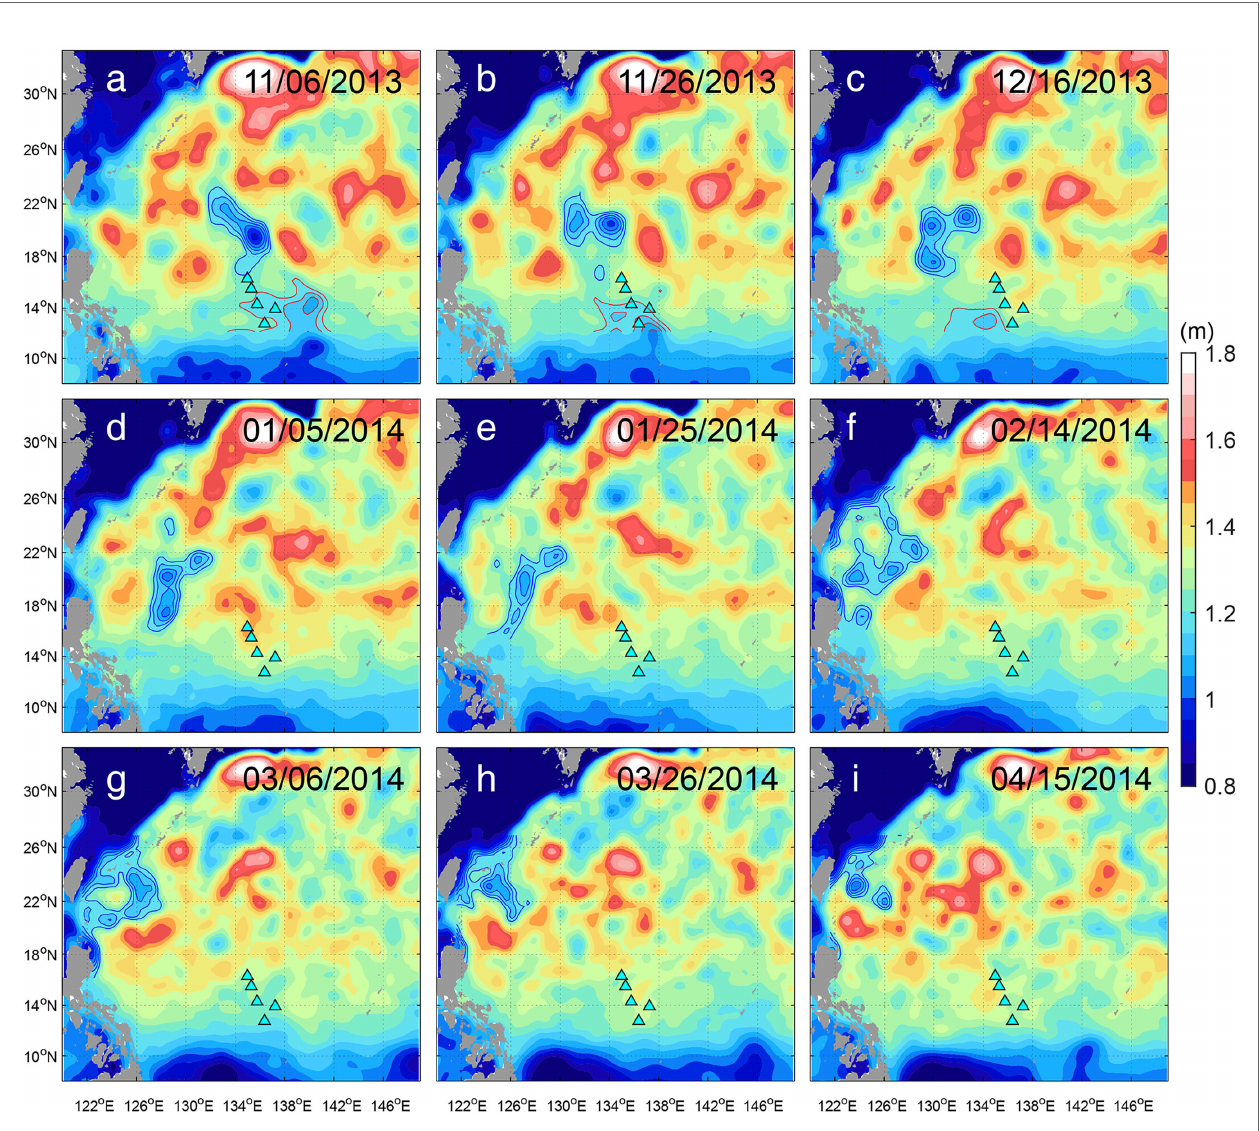
FIGURE 5 | (A – I) Snapshot of sea-surface height (SSH) maps in the western Paci fi c during the westward propagation of the typhoon-enhanced cold eddies. Snapshots of SSH is every 20 days from November 6 th in 2013 to April 15 th in 2014. Pressure-recording inverted echo sounder (PIES) mooring sites are indicated by cyan triangles. Blue and red contours are from 0.9 to 1.2 m with 0.05 m